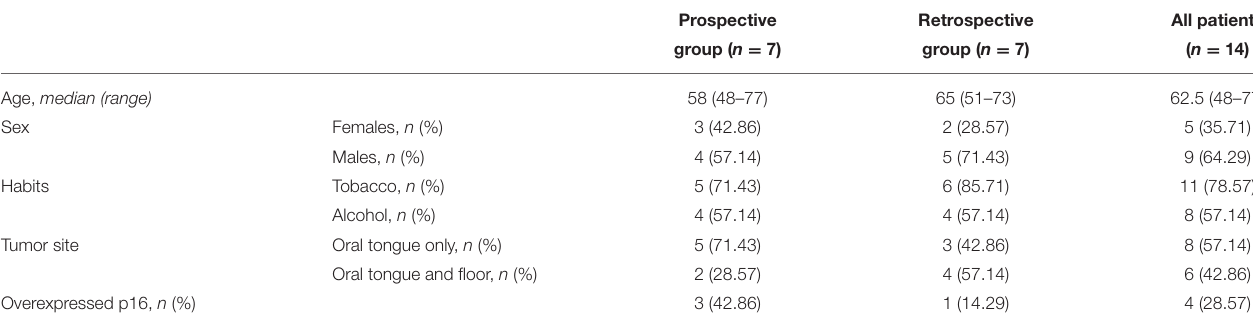
TABLE 1 | Demographic and clinical data for the 2 groups and for all the patients.